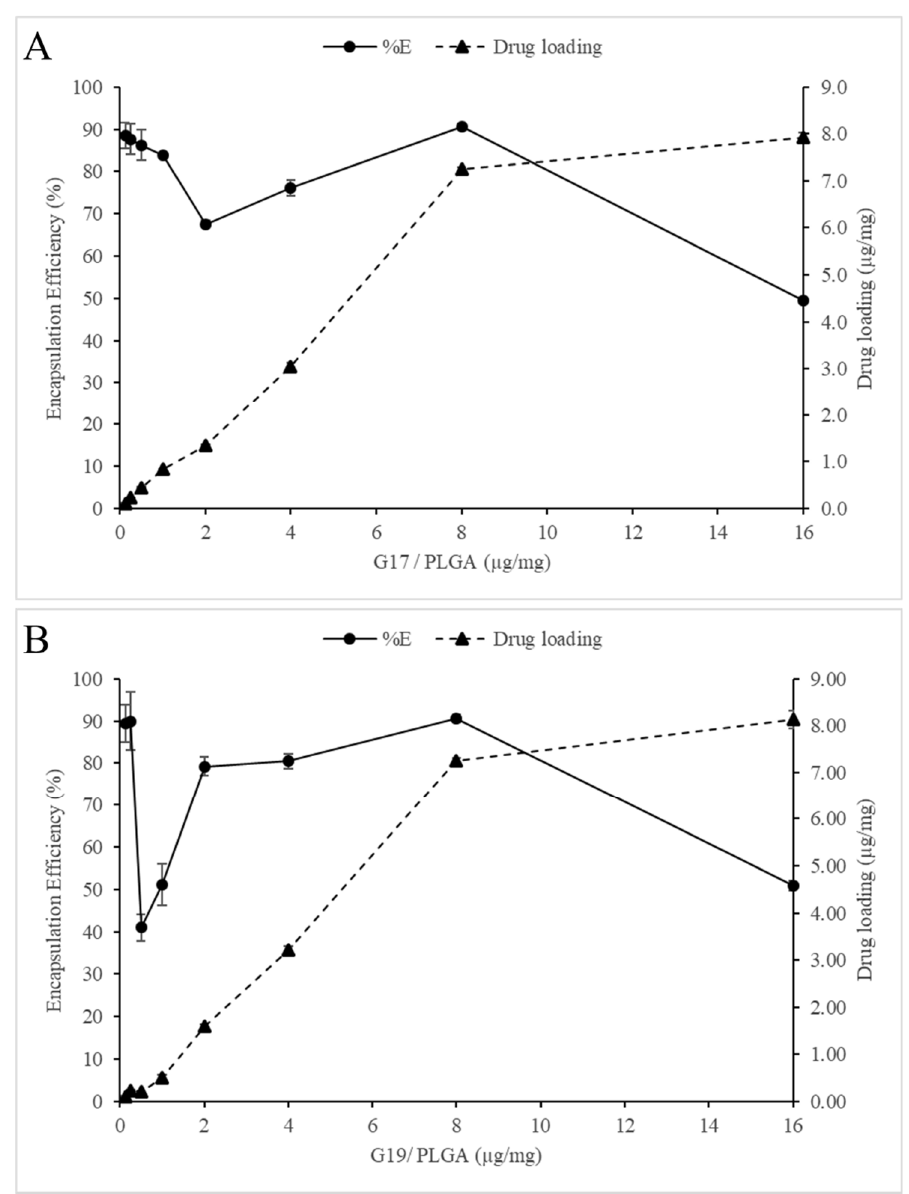
encapsulation efficiency in PLGA nanoparticles. Data are the mean ± SD (n =